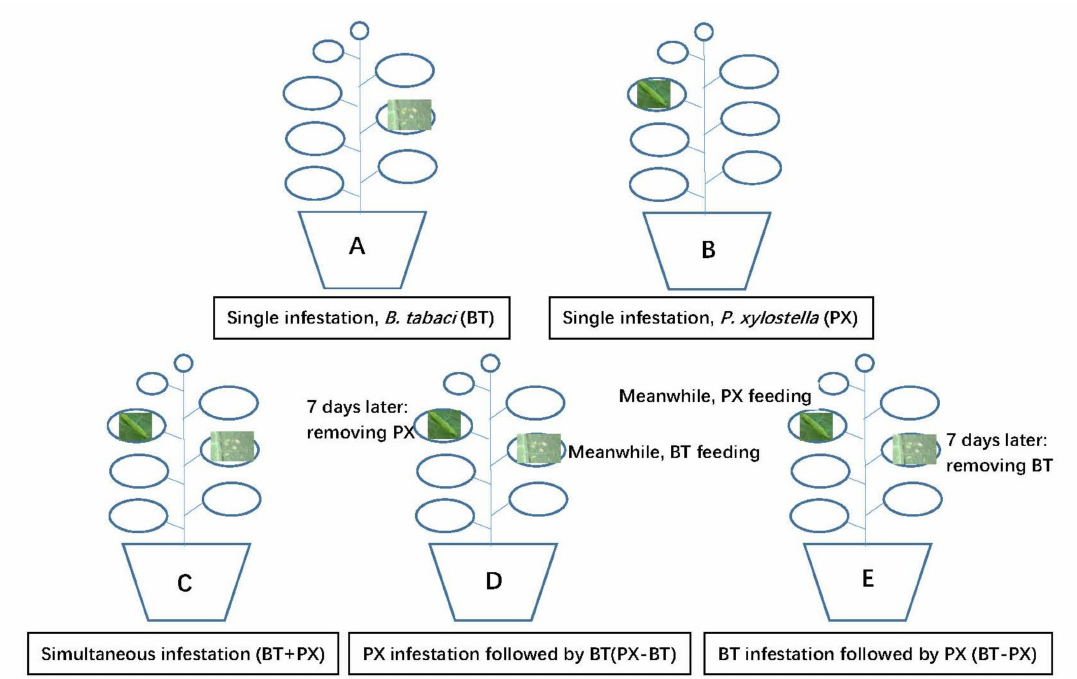
Figure 1. Schematic illustration of experimental setup. Bemisia tabaci (BT) and Plutella xylostella (PX) performance and fitness benefits were evaluated when feeding as single herbivore on Chinese kale ( A , B , respectively), on plants with prior herbivore damage ( D , E , respectively) and with simultaneous damage ( C